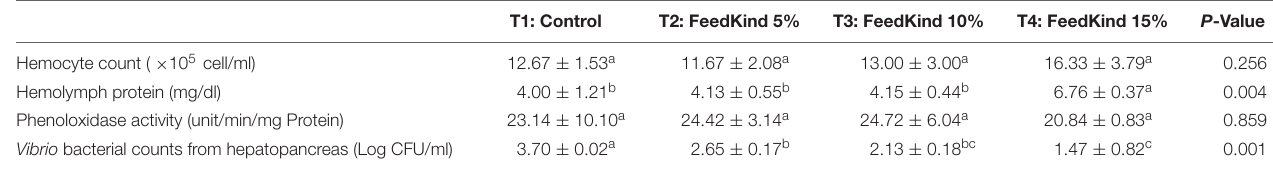
TABLE 6 | Immune parameters in white shrimp fed different levels of methanotroph bacteria meal after 15 days of immersion by Vibrio parahaemolyticus. T1: